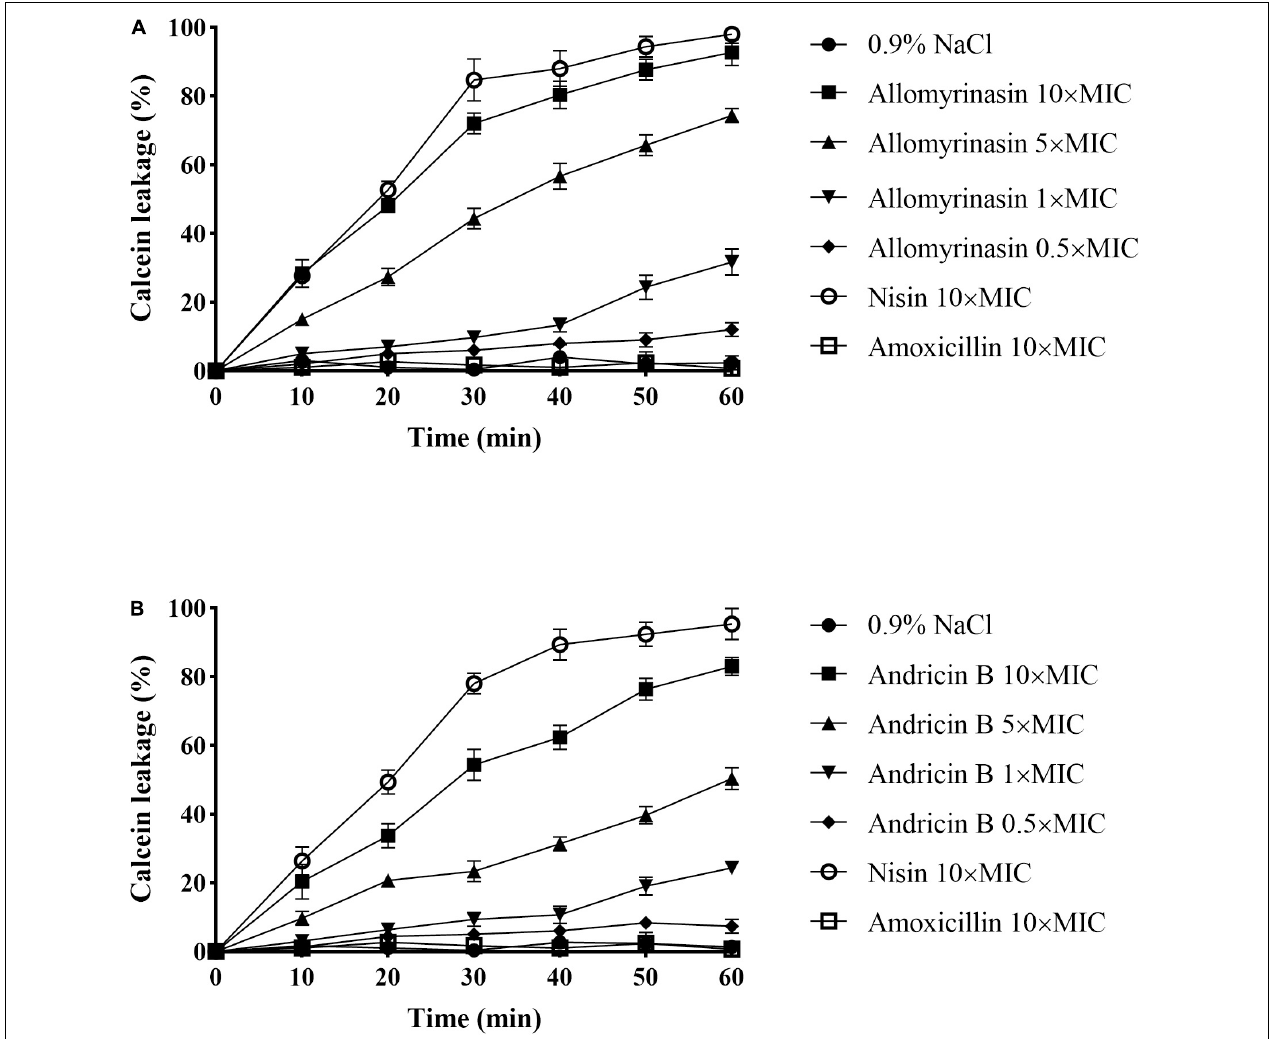
FIGURE 5 | Cytoplasmic membrane permeabilization of Staphylococcus pseudintermedius MW767056 as a consequence of actions of allomyrinasin (A) and andricin B (B) at 0.5, 1, 5, and 10 × minimal inhibitory concentration (MIC) µ g/ml, suggested by calcein leakage over 1 h of exposure. All data are shown as the mean ± SD from two independent experiments performed in triplicate.